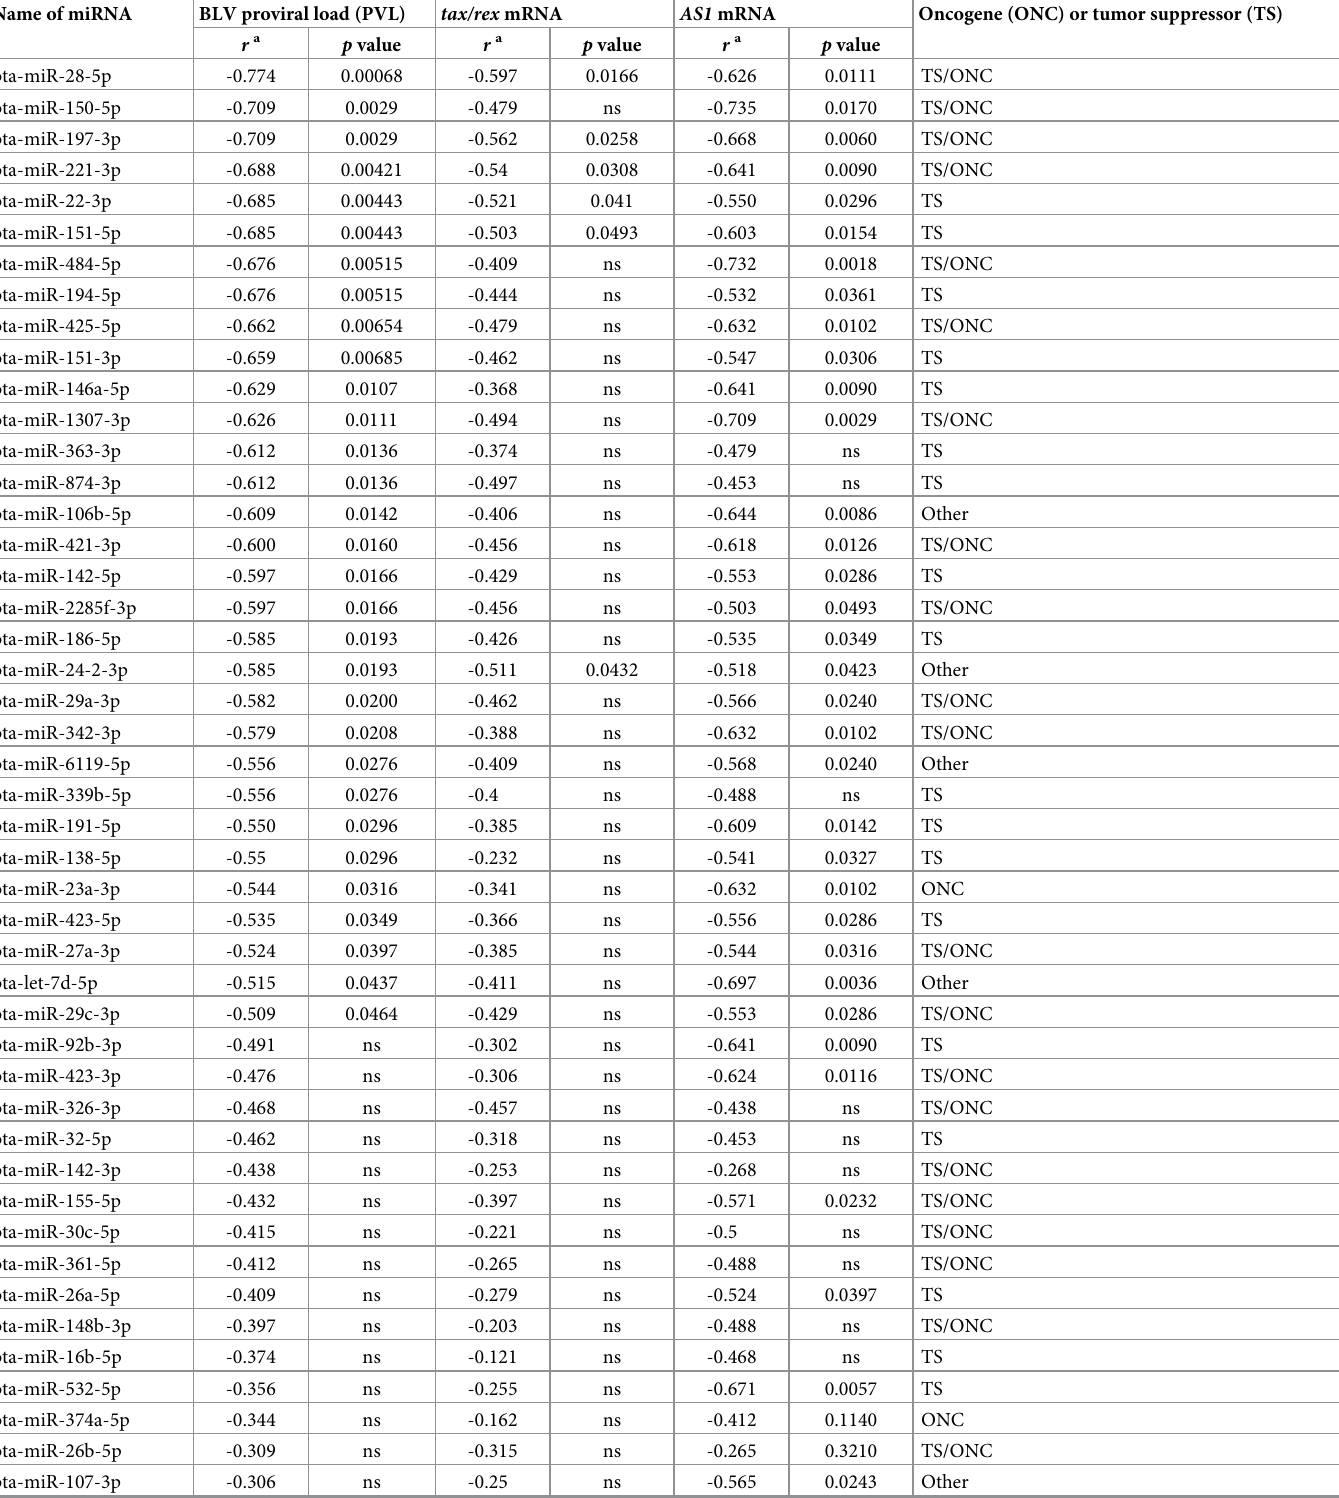
Table 4. Correlation between bta-miRNA sequencing reads and BLV proviral load (PVL) and AS1 mRNA